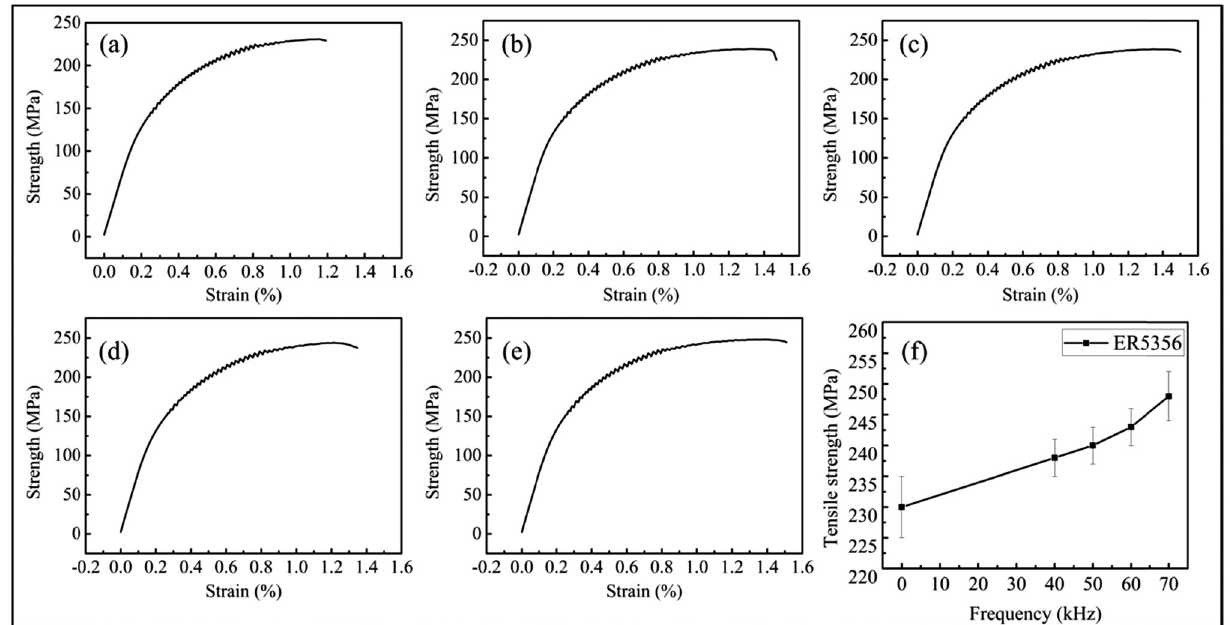
Figure 12: Stress – strain curves and tensile strength of weld joints made with different frequencies: ( a ) 0 kHz, ( b ) 40 kHz, ( c ) 50 kHz, ( d ) 60 kHz, ( e ) 70 kHz, and ( f ) tensile strength.